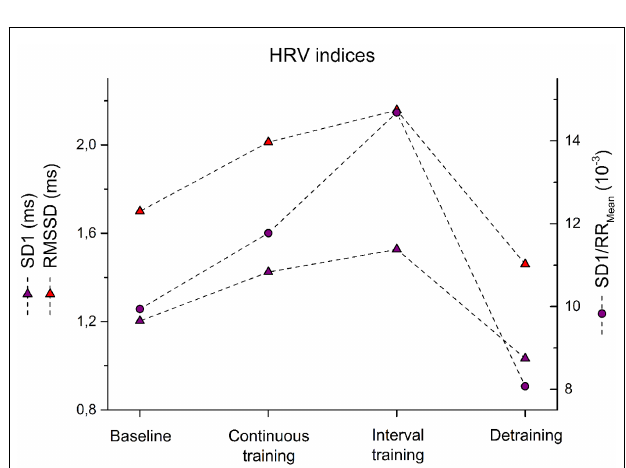
FIGURE 2 | Heart rate (beat-to-beat) during graded cardiopulmonary exercise test (CET) on a bicycle before training (baseline), after 6 weeks of continuous training, 6 weeks of interval training, and 6 weeks of detraining .